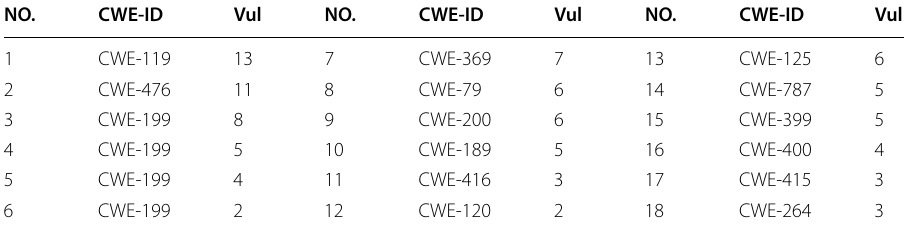
Table 3 Type and number of vulnerabilities in testing dataset